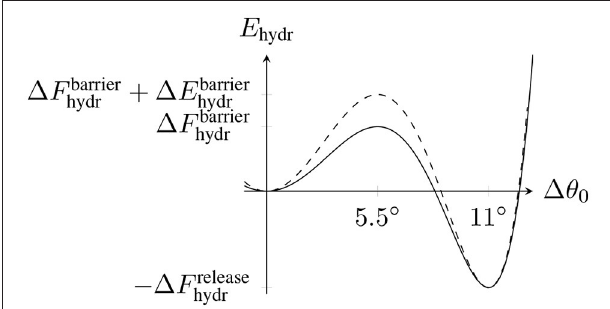
FIGURE 3 | Schematic hydrolysis energy landscape with two local minima corresponding to the straight conformation ( 1θ 0 = 0 ◦ ) and the bent conformation ( 1θ 0 = 11 ◦ ) and an energy barrier 1 F barrier hydr at 1θ 0 = 5.5 ◦ between them. 1 F release hydr is the energy released by hydrolysis. The dashed line represents the modified energy landscape due to the dimer-dependent contribution E hydr ( 1θ 0